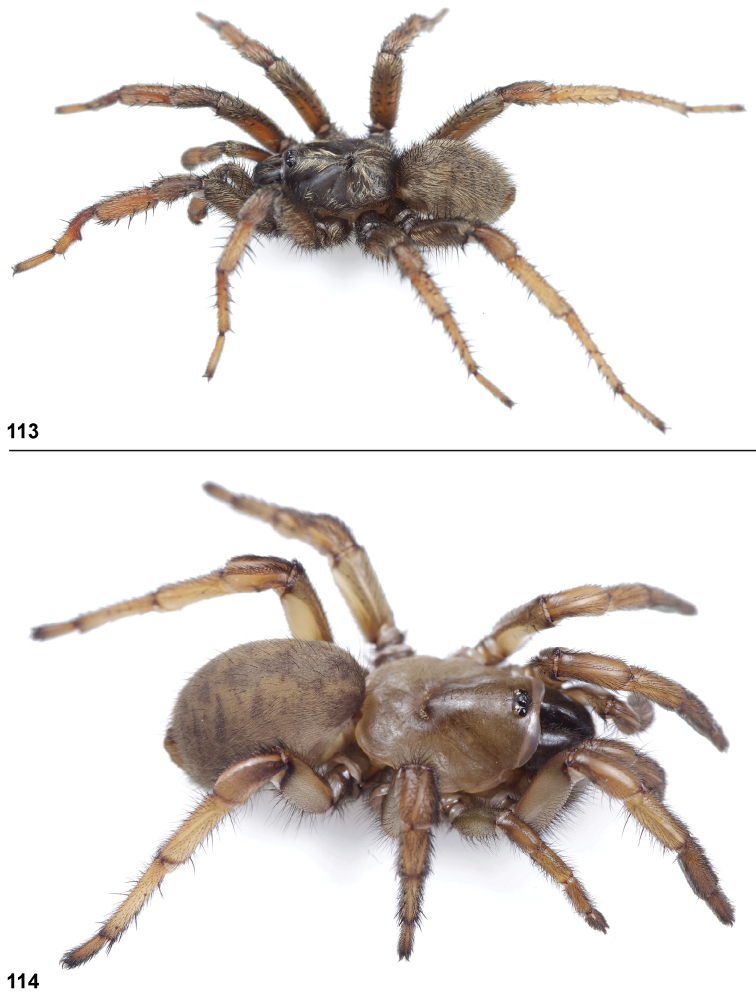
Aptostichus stanfordianus specimens from Sonoma Co., Santa Rosa, live photographs. 113 male specimen (AUMS32) 114 female specimen (AUMS35).